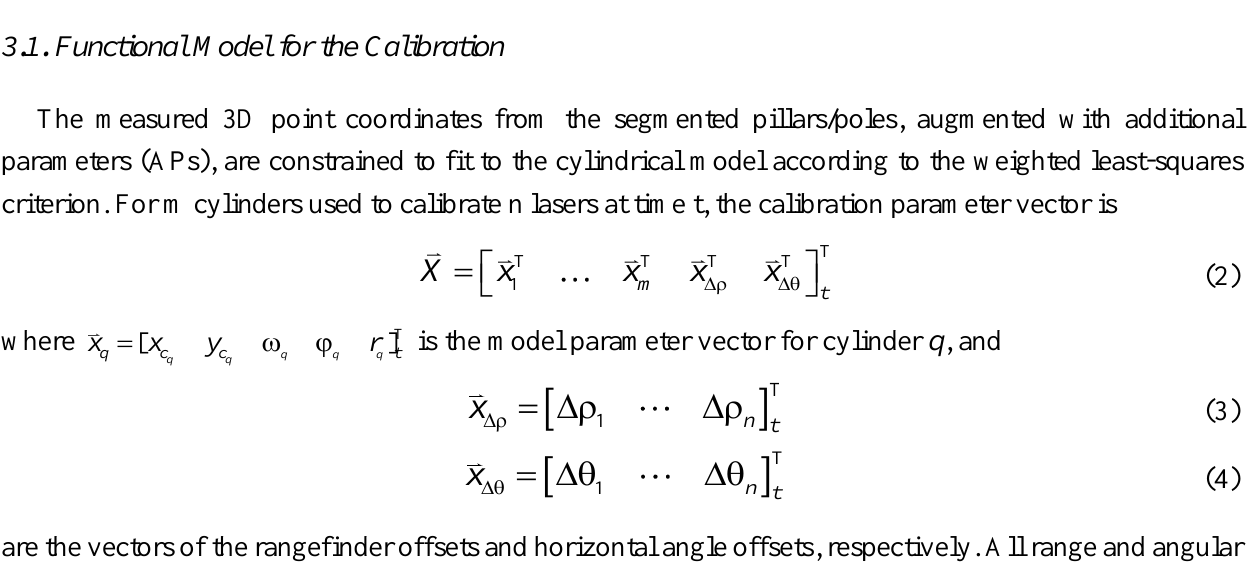
Figure 6. Proposed automatic calibration method in kinematic